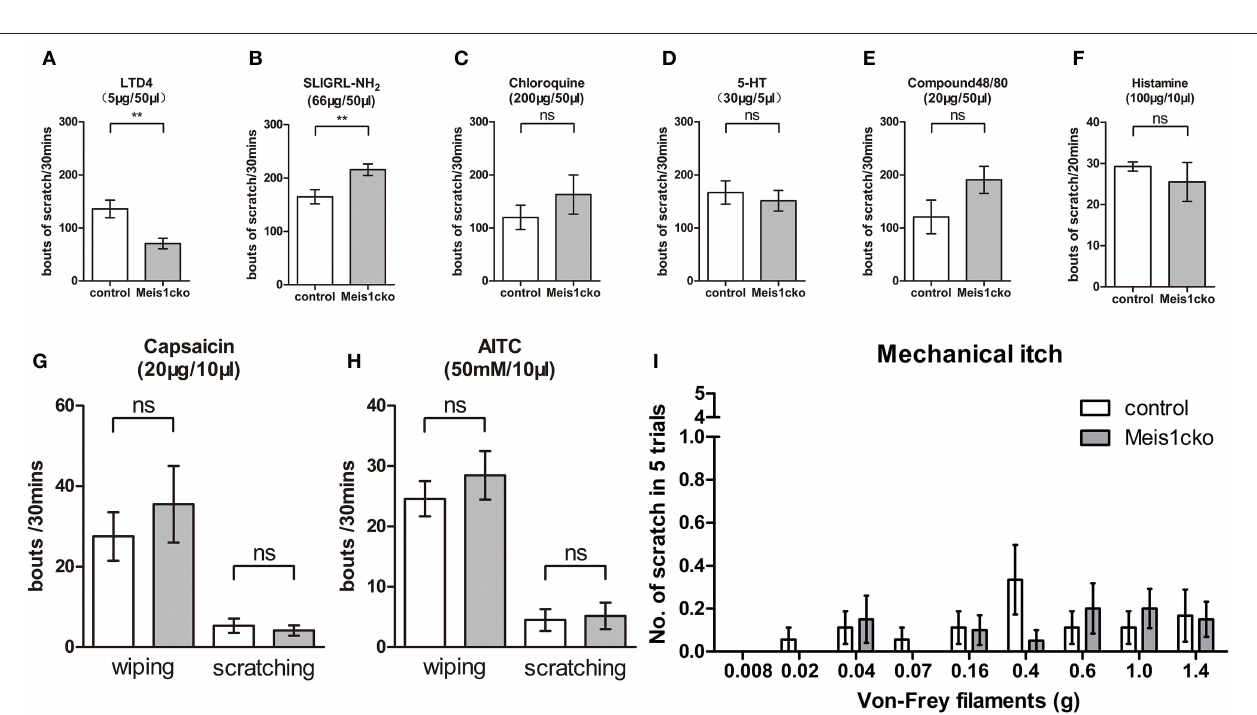
FIGURE 6 | Attenuated response to LTD4-evoked itching in Mesi1cko mice. (A) The number of scratching events induced by LTD4 was significantly reduced in Meis1cko mice (136 ± 17 in control mice vs. 71 ± 10 in Meis1cko mice, n = 8 mice per group; p = 0.0046). (B) Scratching bouts induced by SLIGRL-NH 2 were marginally but significantly increased in Meis1cko mice (165 ± 13 in control mice vs. 216 ± 11 in Meis1cko mice, n = 10 mice per group; p = 0.0087). (C–F) Control and Meis1cko mice showed comparable scratching behavior in response to an injection of chloroquine [ n = 8; (C) ], 5-HT [ n = 9; (D) ], or Compound 48/80 [ n = 9; (E) ] on the nape of mice, and histamine [ n = 6; (F) ] in the cheek. (G,H) Control and Meis1cko mice showed a normal response to an injection of capsaicin [ n = 6; (G) ] and AITC [ n = 12; (H) ] in the cheek. (I) The shaved napes were stimulated with different von Frey filaments to assess mechanical itch ( n = 18 control mice, n = 20 Meis1cko mice). Error bars represent SEM. Significant differences were determined using unpaired Student’s t -test: ** p < 0.01 ns, Not